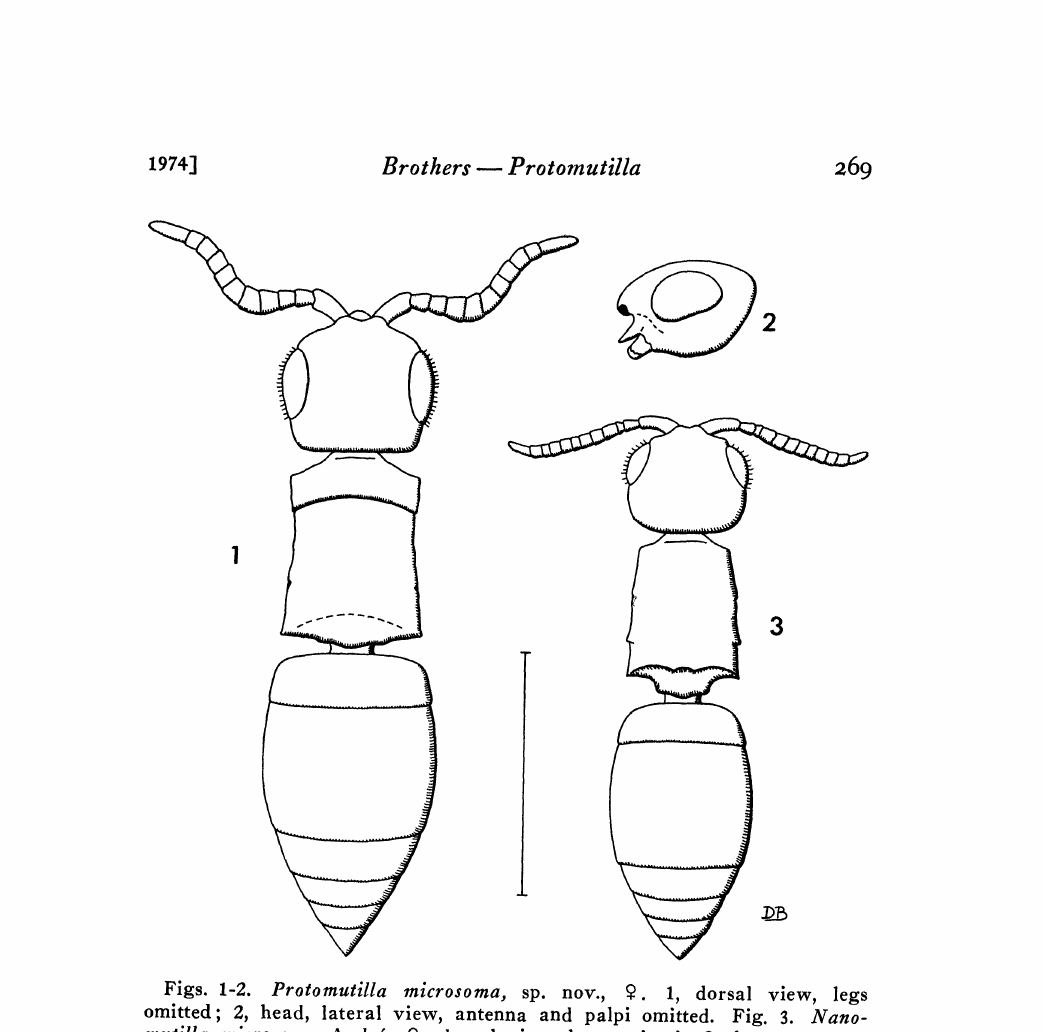
. , Figs. 1-2. Protomutilla microsoma, sp. nov., 1, dorsal view, legs omitted; 2, head, lateral view, antenna and palpi omitted. Fig. 3. Nano- mutilla microsoma Andr6, dorsal view, legs omitted. Scale 1.0